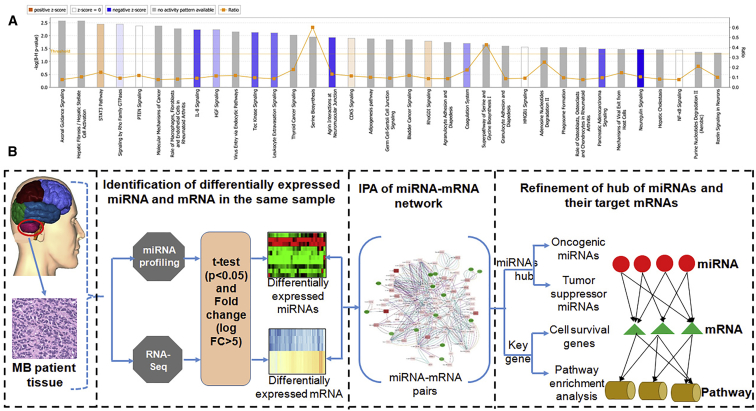
Functional Analysis of the miRNA-mRNA Network(A) IPA of differentially expressed pathways in an MB specimen specific to the cerebellum. Higher (−)log Benjamini-Hochberg (B-H) p value corresponds to the more significant pathway. The solid yellow line in the bar charts reflects the ratio that refers to the number of molecules from the dataset that map to the pathway divided by the total number of molecules that map the canonical pathway from the IPA knowledge base. Z score is the activation score for a pathway or disease or function. The Z score reflects how much the pathway or function is activated (orange) or deactivated (blue) due to the changes in the expression of genes involved in those pathways or functions. (B) Illustration of the design of miRNA-mRNA target binding in a human MB specimen. Expression profiles of miRNAs and mRNA and their correlation in the same MB sample are used to discover the complex miRNA-mRNA interaction.